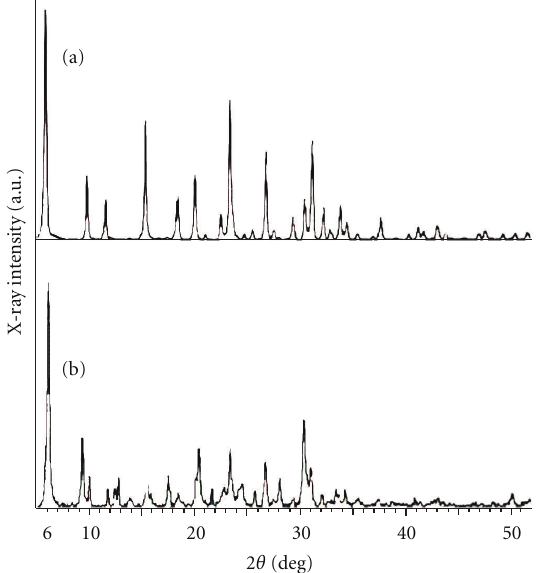
Figure 1: XRD patterns of (a) the pure phase zeolite Y and (b) the pure phase nanozeolite Y.